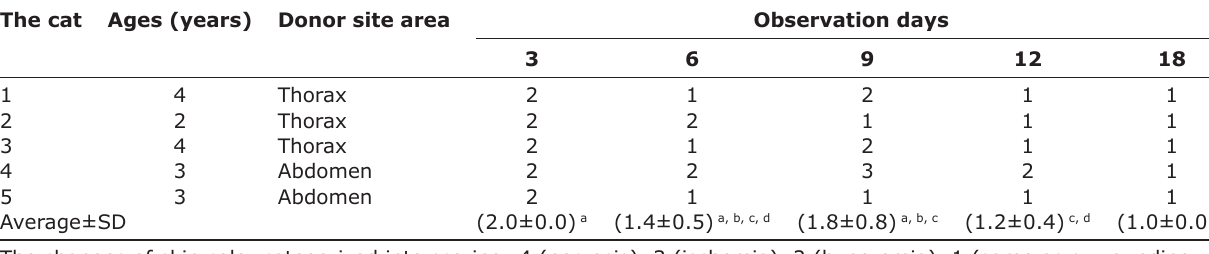
Table-1: Observation of subjective distant skin flap color changes. The cat Ages (years)